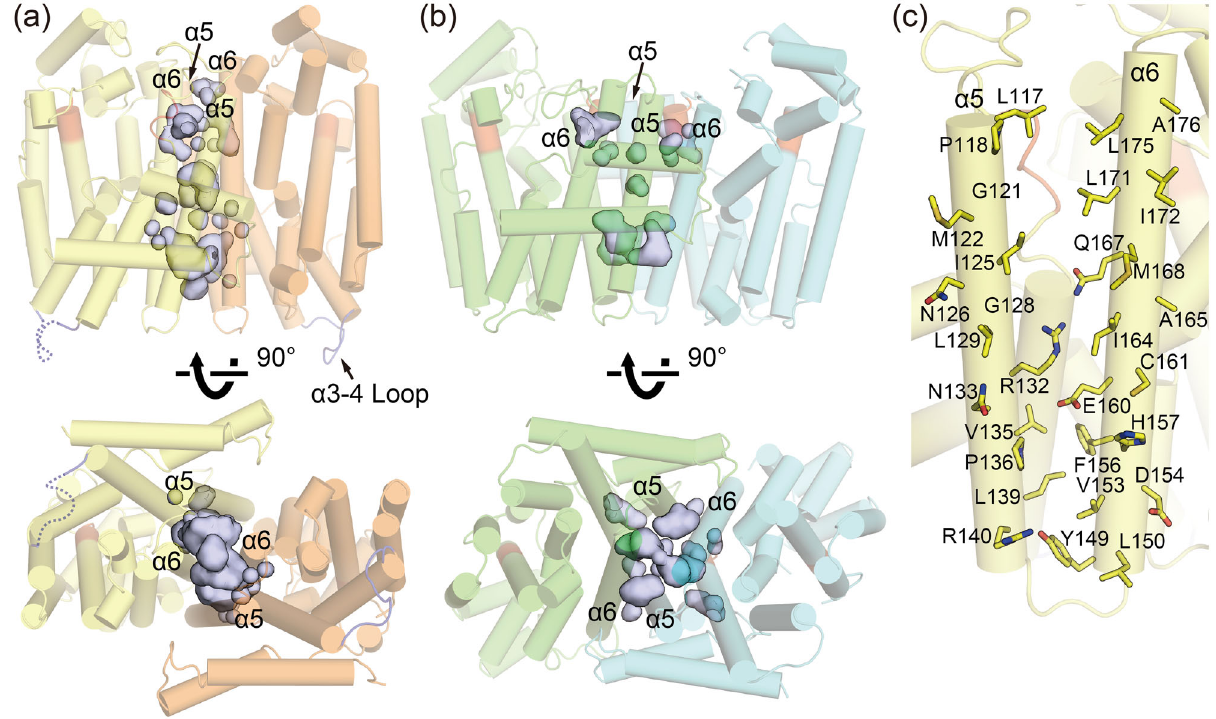
Fig. 4 Central cavities of EuTPT3 and EuFPS1. Side and bottom views of a EuTPT3 and b EuFPS1 with the central cavities shown as gray surface model. Cavities were generated by PyMOL. Cartoon ribbon models of EuTPT3 and EuFPS1 are shown transparently. The DDxxD motif regions are colored in red. The α 3 – 4 loops of EuTPT3 are colored in dark blue. The dashed line represents the untraceable α 3 – 4 loop in chain A of EuTPT3. c Amino acids constructing the central cavity of